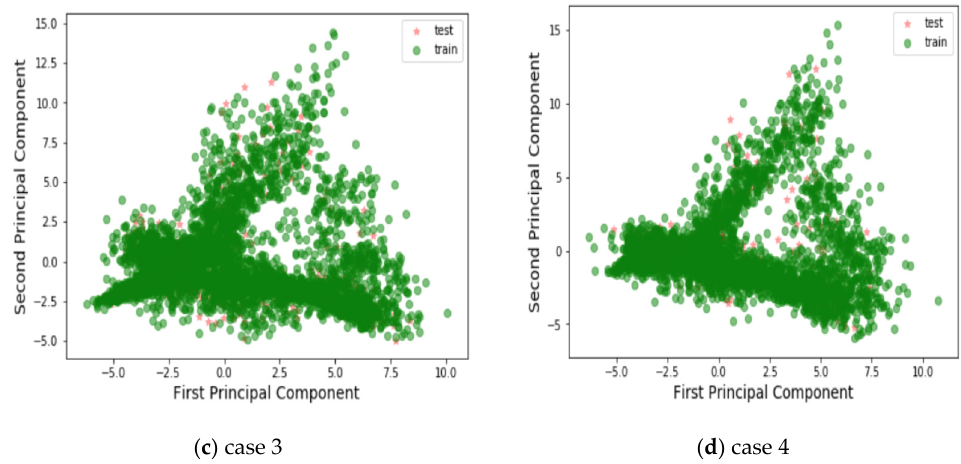
Figure 5. Principal component analysis plot. ( a ) Case 1 ‐ PCA plot for morning. ( b ) Case 2 ‐ PCA plot for afternoon. ( c ) Case 3 ‐ PCA plot for forward. ( d ) Case 4 ‐ PCA plot for backward.